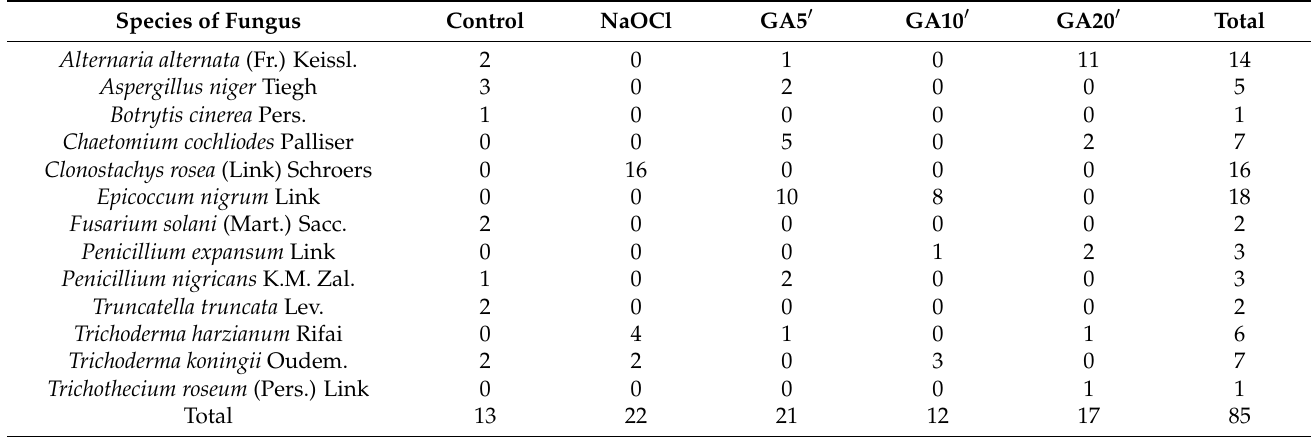
Table 5. Fungal species on Beta vulgaris.